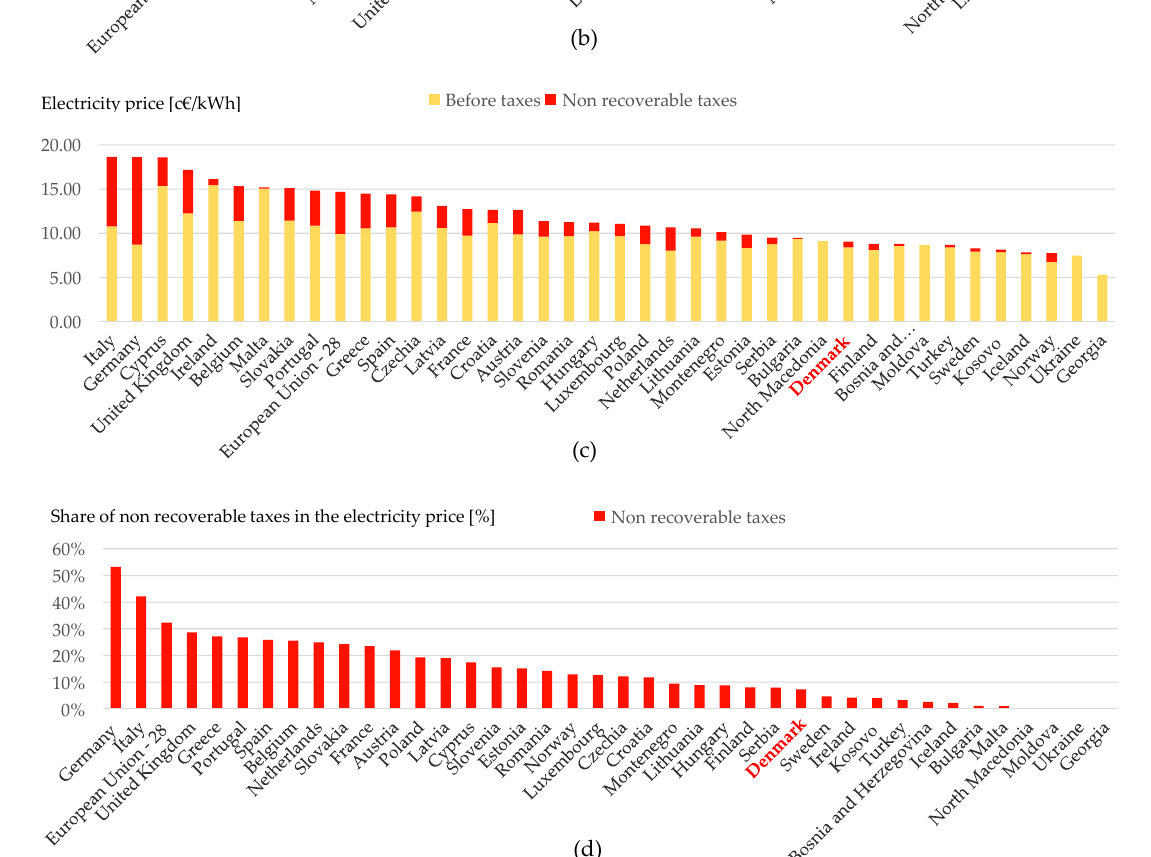
Figure 6. EU and selected neighbouring countries data for 2019 2nd semester: household electricity price ( a ) and its share of taxes ( b ); non-household electricity price ( c ) and share of non-recoverable taxes ( d ). Self-elaboration.